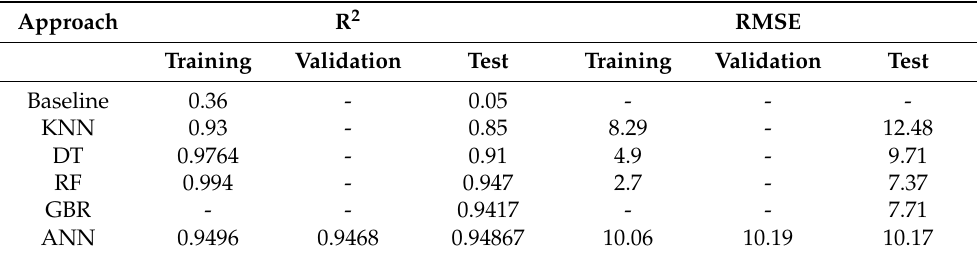
Table 2. Performance comparison of the baseline and five ML algorithm models for RSSI prediction in terms of R-squared (R 2 ) and root mean square error